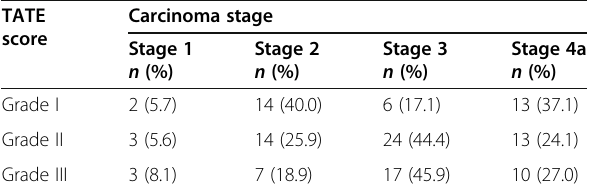
Table 4: Showing association between lymph node involvement and TATE score